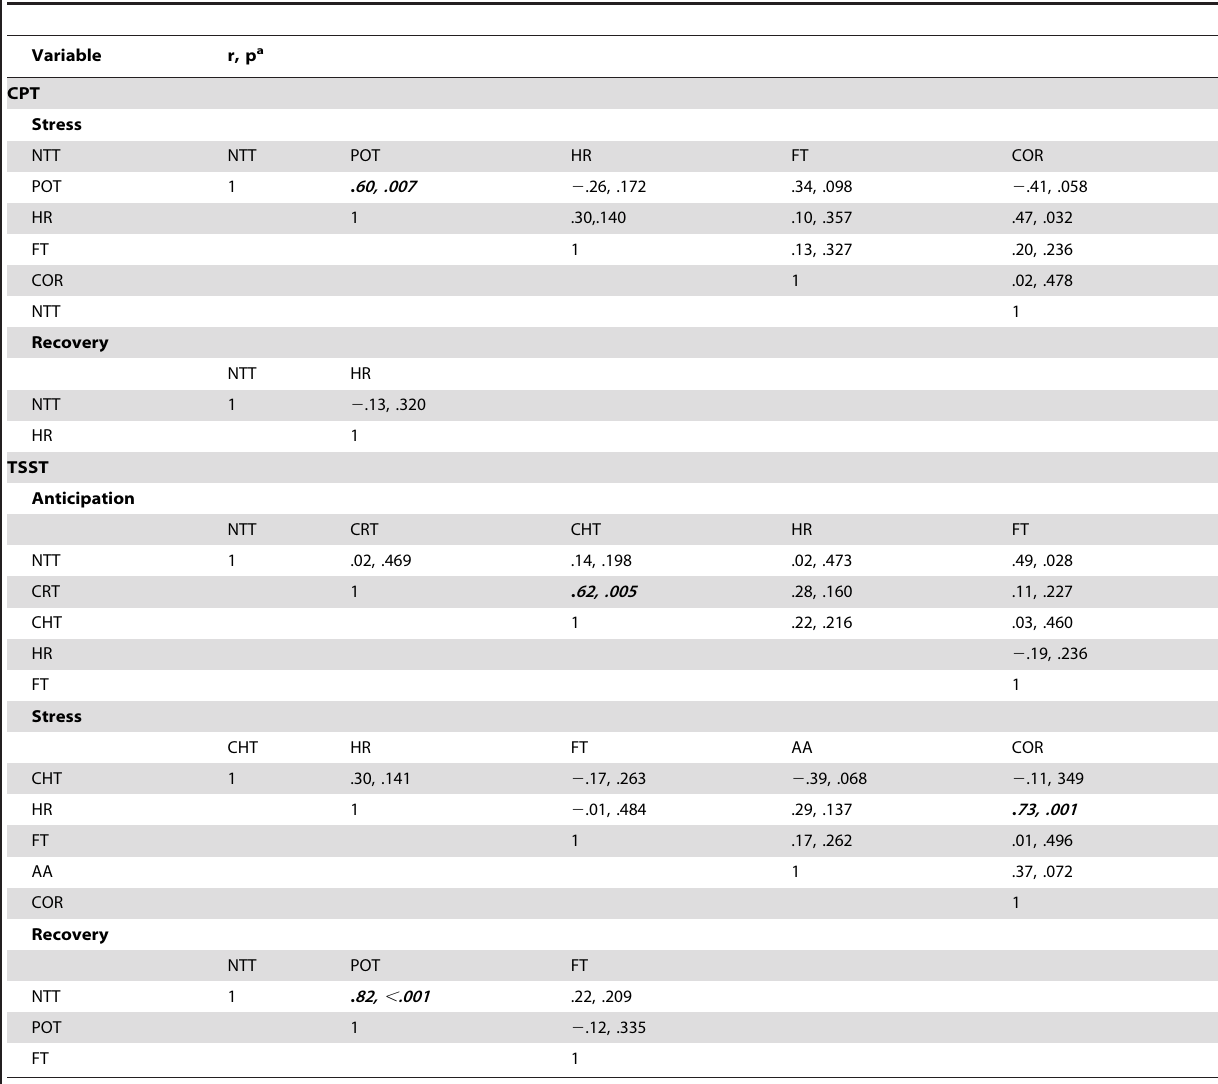
Tables 3. Pearson correlations between the change-sensitive candidates for each test phase in CPT and TSST.